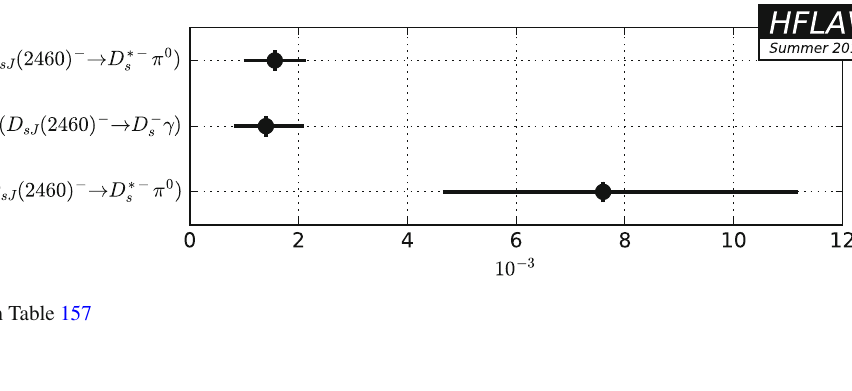
Fig. 126 Summary of the averages from Table